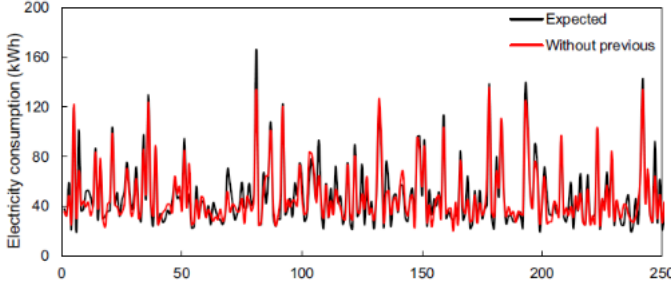
Fig. 5 BP neural network prediction and actual value comparison under the colour histogram.